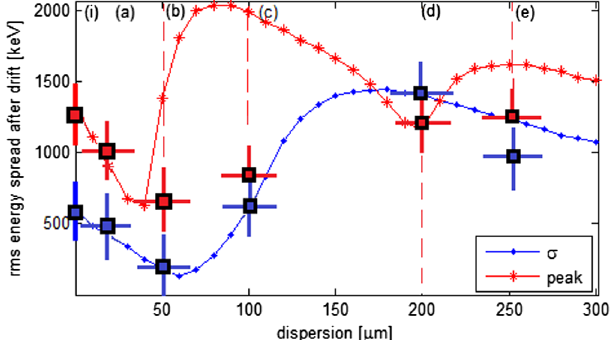
FIG. 5. Simulation of the final rms energy spreads of seeded microbunches with initial energy modulations of 0.65 and 1.3 MeV (rms) corresponding to particles at σ and the peak of the seeded region in Fig. 4(a) – (e). Energy spread values derived from Fig. 4(a) – (e) are plotted as red and blue squares. The point labeled (i) corresponds to the expected energy modulation for measured laser and undulator parameters. Horizontal bars reflect the uncertainty in the longitudinal dispersion determined by magnet hysteresis. The dashed lines extending upward and downward indicate measurement points which had a possible systematic error due to temporal smearing of sharp structures. The error bars are given by the differences between energy modulations associated with the color-code derived from Fig. red and the conditions at a distance of σ from the center are in blue. The curves are given by simulations and the vertical bars are given by the Fig. 4(a) – (e) measurements. Vertical error bars are given by 70% of the difference between the energy modulations corresponding to different colors.